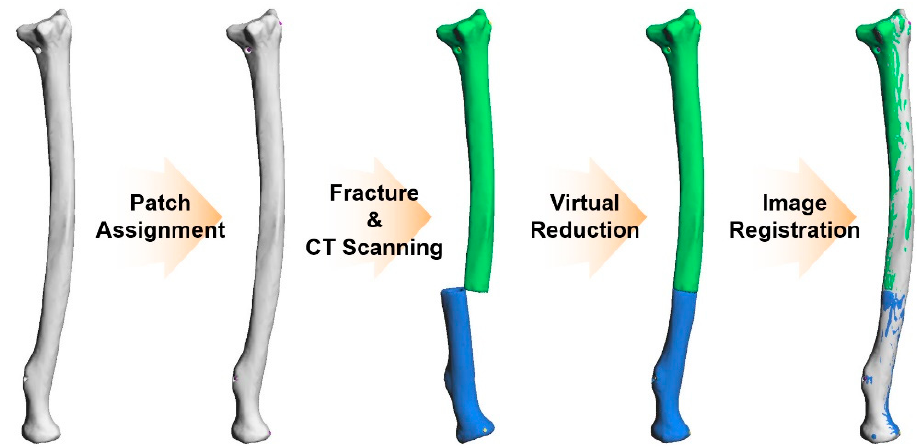
Figure 2. Scheme of the workflow for virtual reduction and image registration between the virtually reduced object and the original object. (1) CT scanning of the original bone, (2) assignment of patches at the cortical marking holes, (3) fracture of the ORTHObone, (4) CT scanning of the fractured bone, (5) virtual reduction, and (6) image registration.